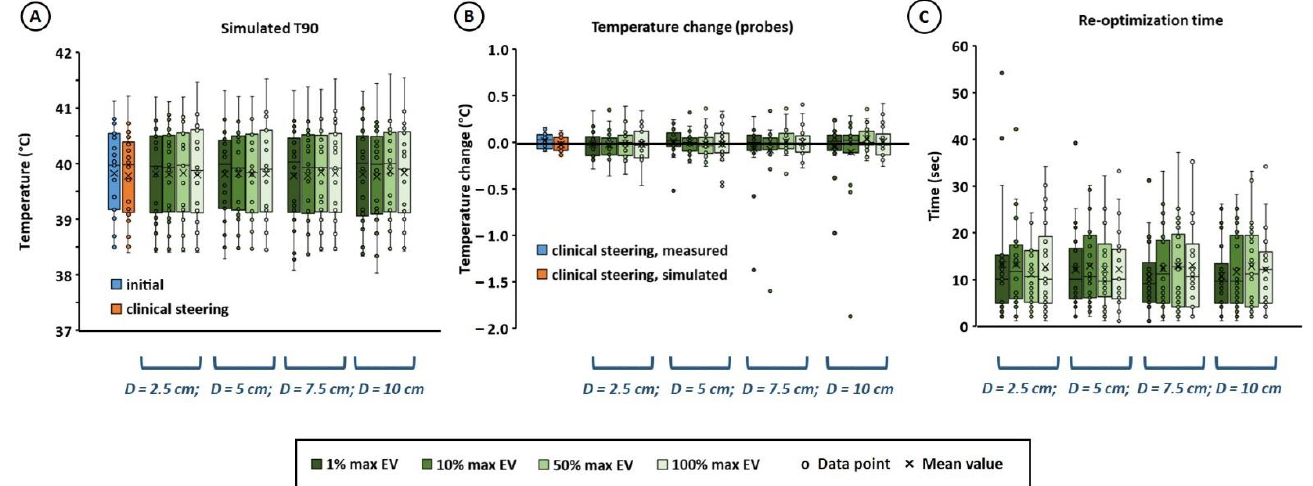
Figure 5. Effect of potential hot spot diameter ( D = 2.5, 5, 7.5 or 10 cm) on the simulated T90 ( A ) and on the temperature change along the thermometry probes ( B ), when using a re-optimization goal function with a penalty term for the maximum increase in all potential hot spot temperatures (Equation (3)). The re-optimization calculation time is indicated in ( C ) for an Intel Xeon ® E5-1650 v3 3.5 GHz running CentOS 6.8. Results are compared to simulations for the clinically applied protocol/experience-based steering strategy during treatment ( A , B ), as well as to probe measurements ( B ). To efficiently calculate a hot spot temperature during optimization, the average temperature of the voxels with the x% largest heating potential was calculated, which are the voxels with the largest maximum eigenvalues (EV) of their temperature matrix ( T in Equation (2). Values of x of 1, 10, 50 and 100% were evaluated.